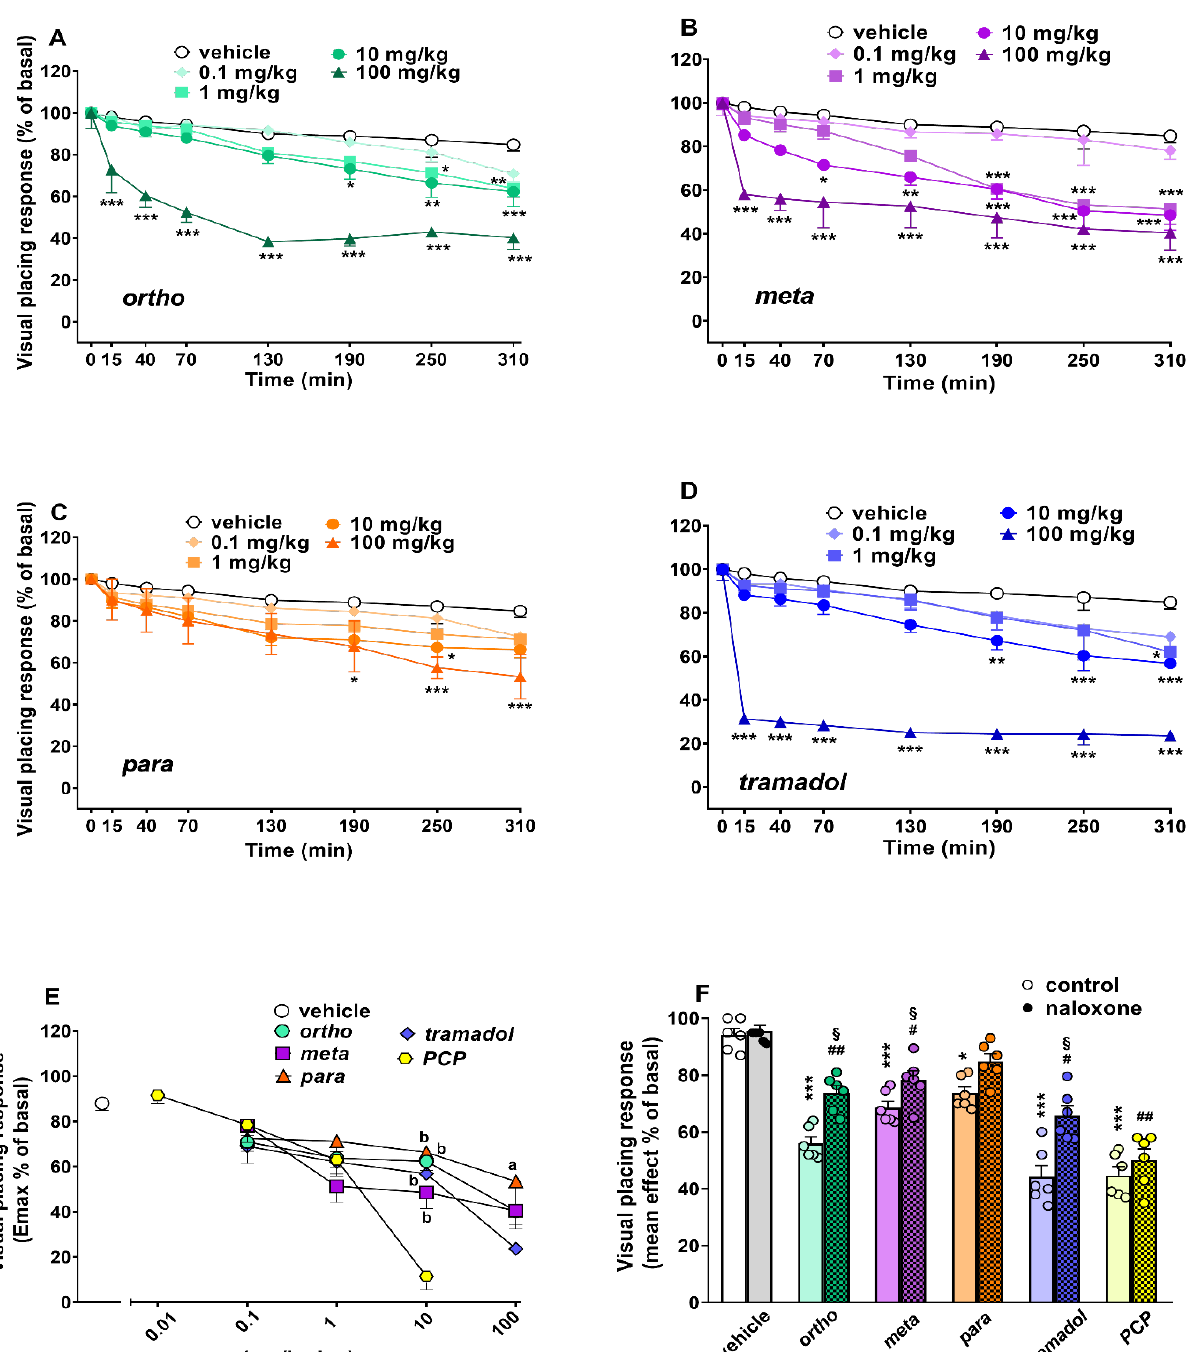
Figure 4. Effects of the systemic administration (0.1–100 mg/kg i.p.) of ortho ( A ), meta ( B ), para ( C ) and tramadol ( D ) on the visual placing test in mice. Comparison of the maximal effect of ortho, meta, para, tramadol (0.1–100 mg/kg) and PCP (0.01–10 mg/kg) observed in 5 h ( E ) 2 . Interaction of the effects of ortho, meta, para, tramadol (100 mg/kg) and PCP (10 mg/kg) with the opioid receptor antagonist naloxone (6 mg/kg, i.p.; ( E )). Data are expressed as a percentage of baseline and represent the mean ± SEM of 6–8 determinations for each treatment. Statistical analysis was performed by two-way ANOVA, followed by the Bonferroni’s test for multiple comparisons for the dose–response curve of each compound at different times ( A – D ), and for the antagonist studies ( F ), while the statistical analysis of ( E ) was performed with one-way ANOVA followed by Bonferroni test for multiple comparisons. * p < 0.05, ** p < 0.01, *** p < 0.001 versus vehicle; a p < 0.05 versus tramadol; b p < 0.05 versus PCP; # p < 0.05, ## p < 0.01 versus naloxone; § p < 0.05 versus without naloxone. 2 PCP data are elaborated from [17].